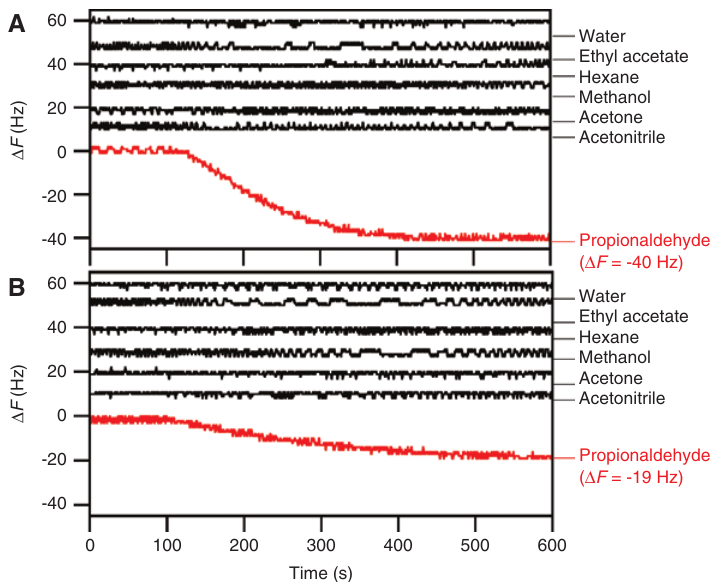
Figure 5: Chemoselective detection of water, ethyl acetate, hexane, methanol, acetone, acetonitrile, and propionaldehyde gases (100 ppb each) all by a multichannel QCM thin coated with (A) SIL 6 and (B) SIL 1 (33 nmol each, 200–300 nm thickness). The QCM sensograms for water, ethyl acetate, hexane, methanol, acetone, and acetonitrile gases were vertically shifted (10 Hz in between) for clarity. Nitrogen was used as the carrier gas with a flow rate of 3 ml/min, and gaseous samples were injected at 100 s. The resonance frequency drop ( Δ F , in Hz) is the QCM response on the quartz chip